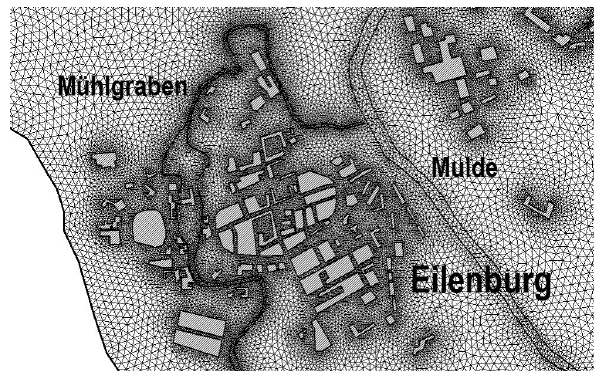
Fig. 1. Investigation area overview and topographical map of Eilen- burg. Figure 1 Investigation area overview and topographical map of Eilenburg.